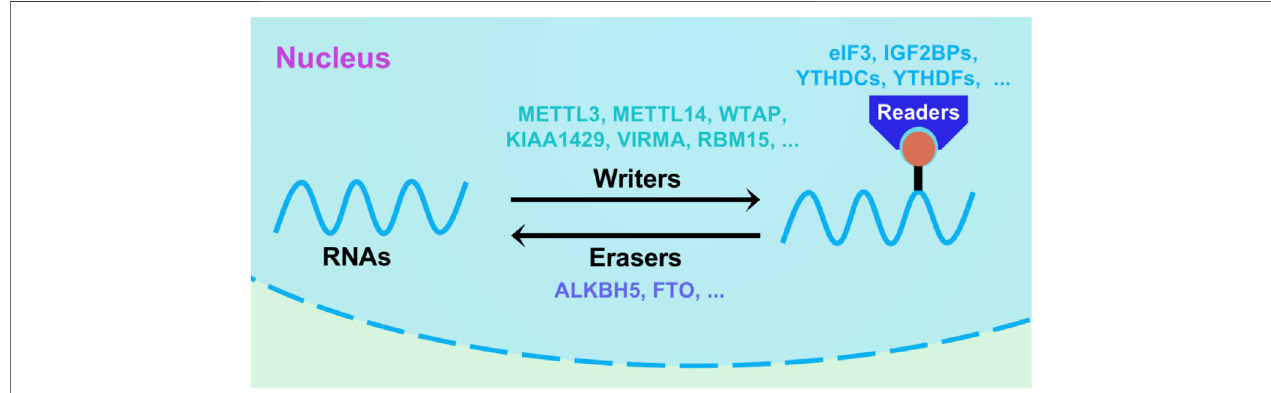
FIGURE 1 | Schematic diagram of RNA m6A methylation mechanism. m6A modi fi cation is a dynamic and reversible process, which could be regulated by writers (WTAP, METTL3/14, KIAA1429, VIRMA and RBM15), erasers (FTO and ALKBH5) and readers (eIF3, YTHDCs, YTDFs and IGF2BPs).